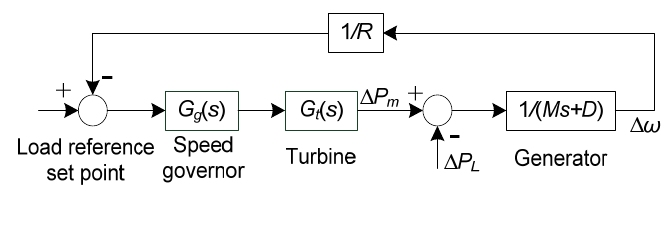
Figure 5. Generating unit